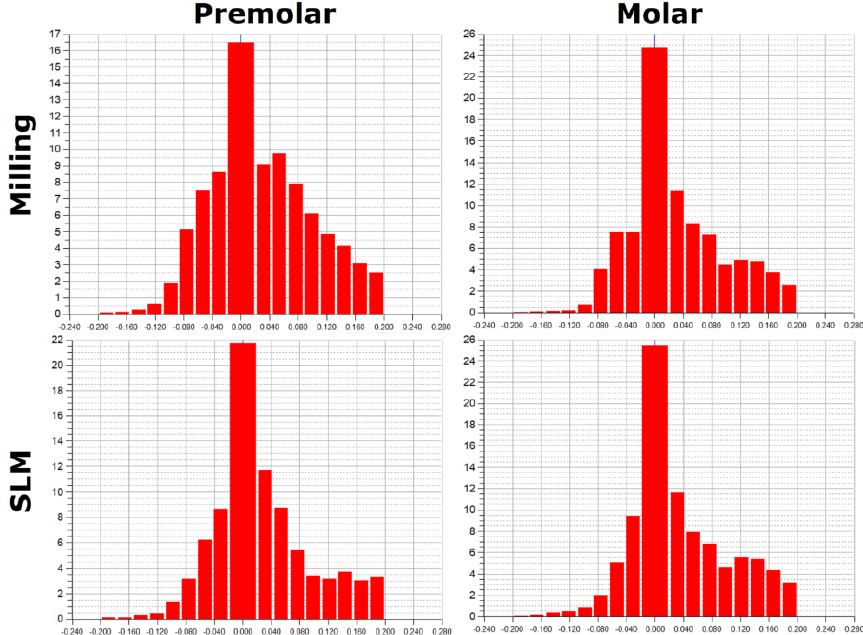
Figure 11. Histograms of the deviation distribution in crowns made of Ti6Al4V alloys for premolars and molars made in SLM and in CAD/CAM milling.